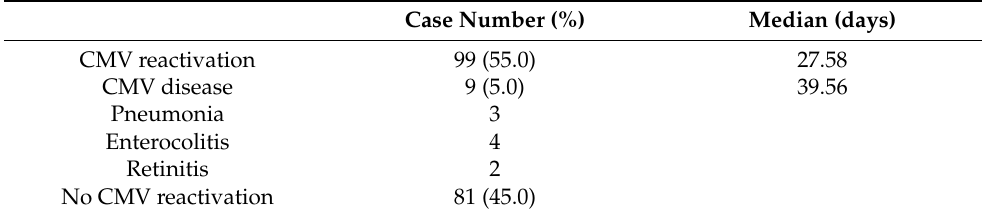
Table 2. Incidence rate of CMV reactivation and CMV